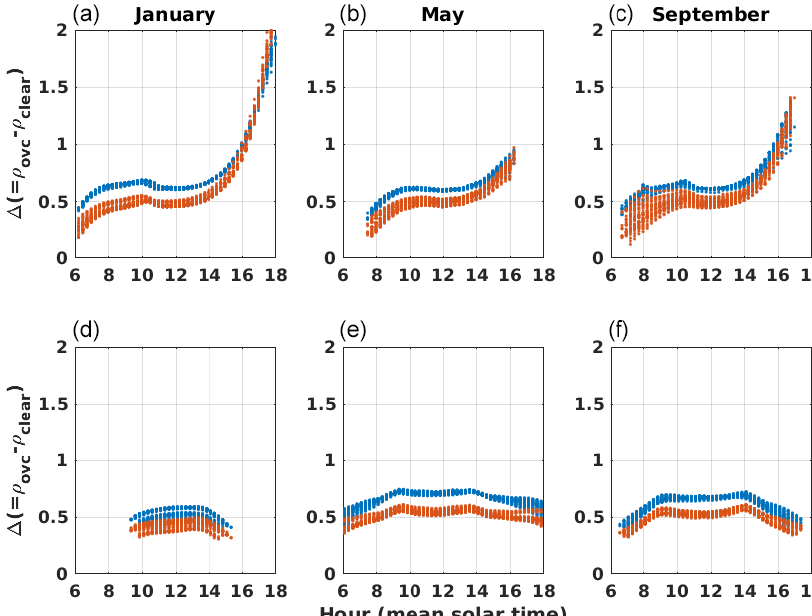
Figure 10. Difference between simulated reflectances at the top of the atmosphere in overcast and clear-sky conditions (cid:49) = ρ ovc − ρ clear for the São Martinho da Serra (Brazil, a–c ) and Camborne (United Kingdom, d–f ) locations and for the January, May, and September calendar months (a, d ; b, e ; c, f) . In blue dots: MSG 0.6µm channel; in red dots: MSG 0.8µm channel.